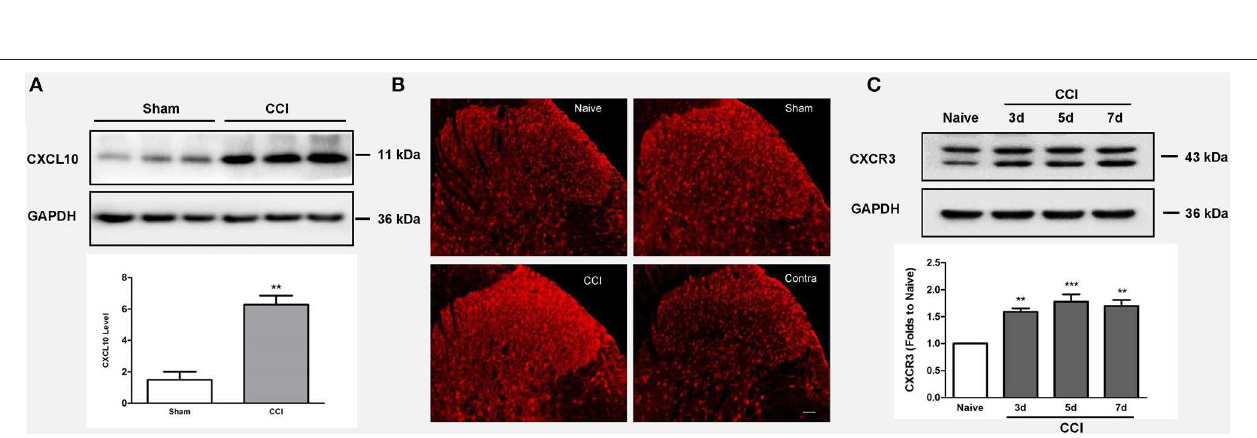
FIGURE 2 | CCI resulted in behavioral hyperalgesia and BSCB disruption. (A) PWTs of hindpaws ipsilateral and contralateral to surgical sites in the sham surgery group and CCI group rats on various experimental days (*** p < 0.001; ANOVA, n = 6). (B) Lumbar spinal cord NaFlu concentrations in the sham surgery group and CCI group rats on experimental day 3 (* p < 0.05; Mann–Whitney U- test, n = 4). The data are shown as means ± standard errors. ANOVA, analysis of variance; BSCB, blood-spinal cord barrier; Contra, contralateral; CCI, chronic constriction injury; Ipsi, ipsilateral; NaFlu, sodium fluorescein; PWT, paw withdrawal threshold.